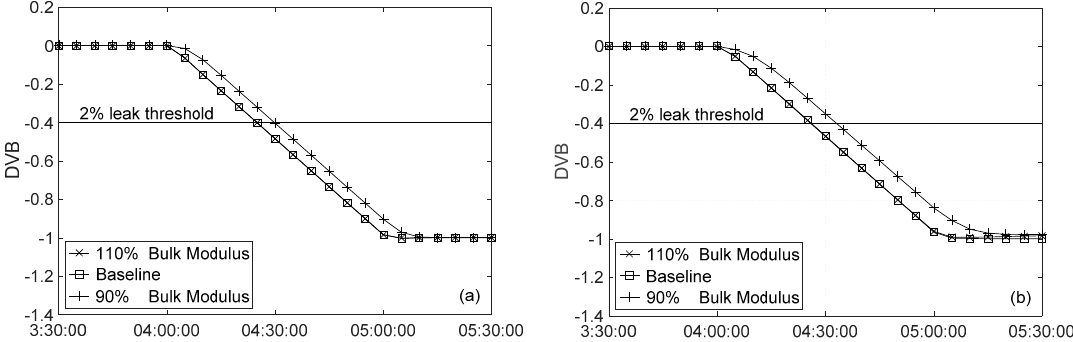
Figure 4. Effect of bulk modulus error on leak detectability in a system with R = 2.20 with perfect data: ( a ) flow decrease; ( b ) flow increase.